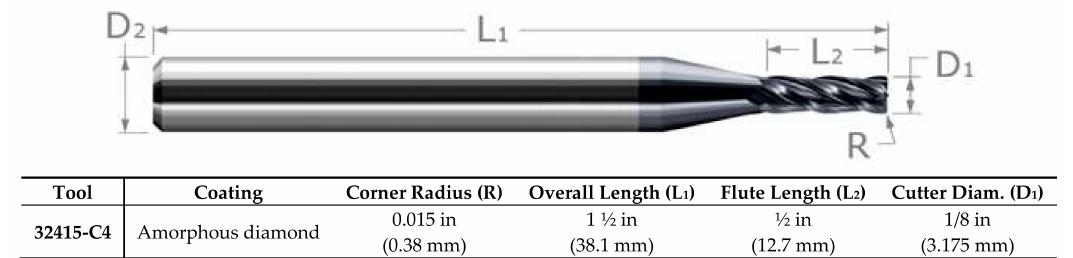
Figure 6. Polycrystalline cubic boron nitride (PCBN) tool coated by PVD amorphous